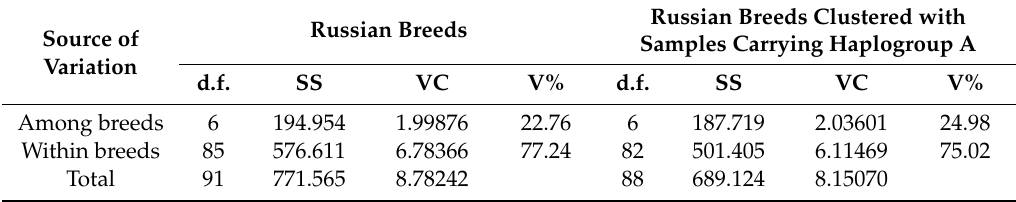
Table 2. Results of analysis of molecular variance (AMOVA) based on the analysis of the D-loop in seven Russian goat